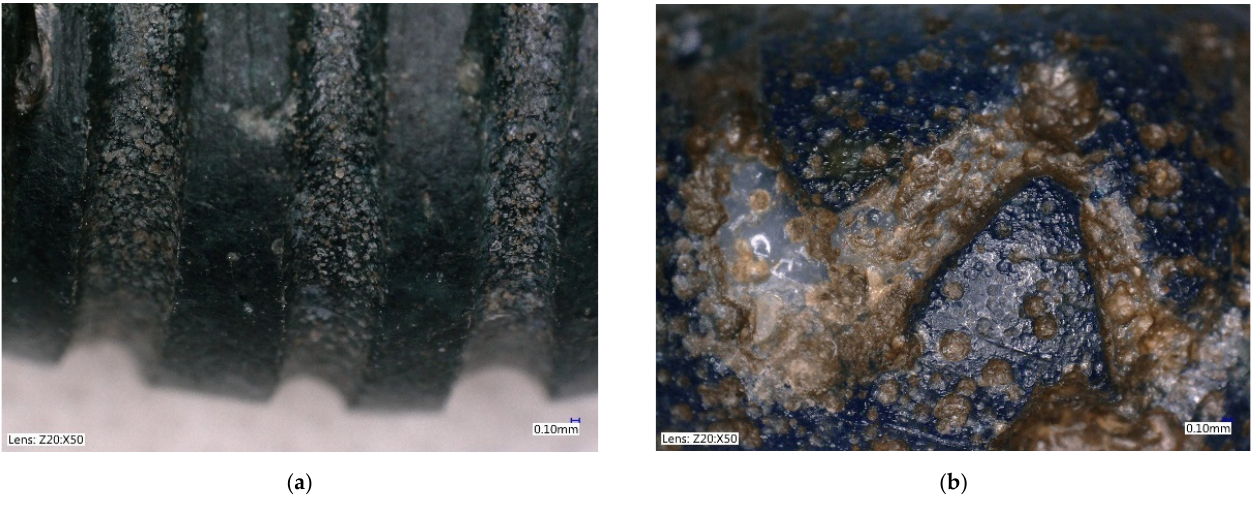
Figure 3. Beads with unpreserved decoration. ( a ) Bead No. 1, residual traces with bubble structure; ( b ) Bead No. 6, remains of light blue fiber.